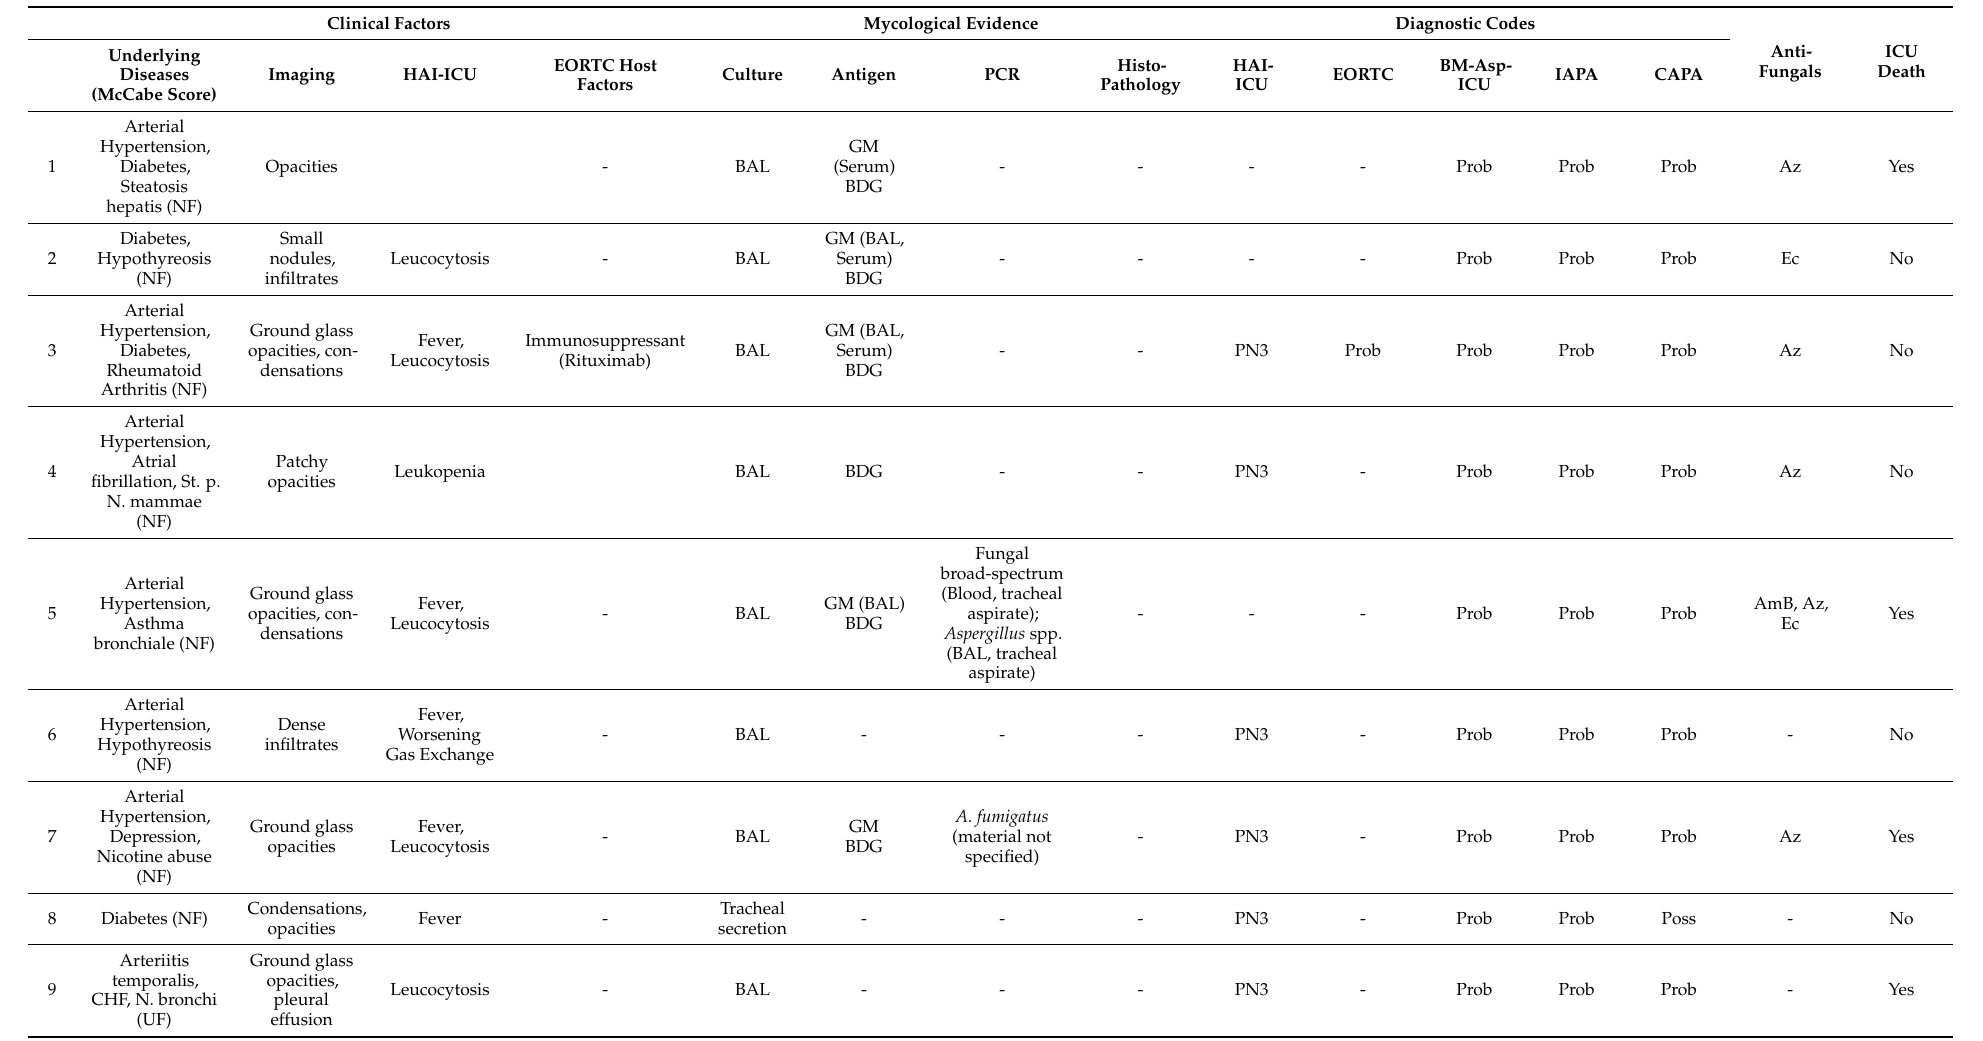
Table 4. Results of diagnostics and treatment for each